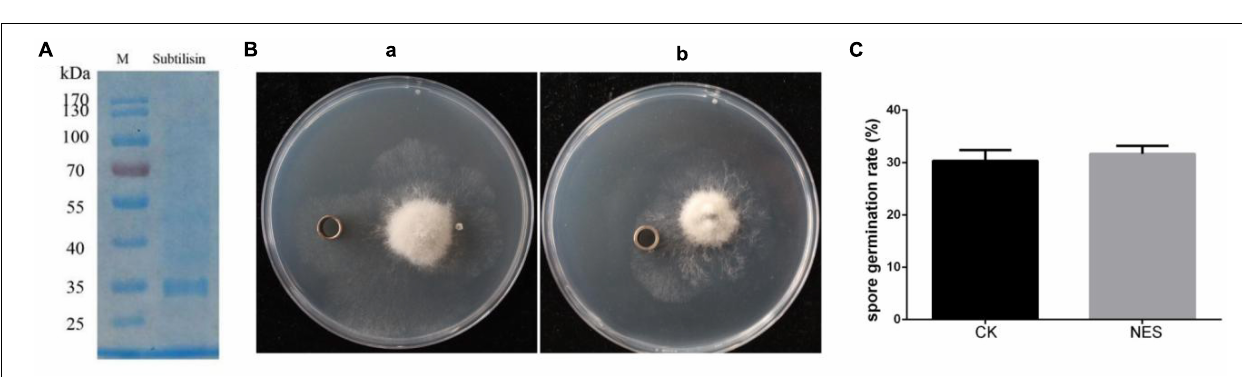
FIGURE 2 | Antifungal effect of subtilisin in vitro . (A) sodium dodecyl sulfate-polyacrylamide gel electrophoresis (SDS-PAGE) image of purified subtilisin protein, Molecular mass markers (M) indicated on the left from top to bottom is 170, 130, 100, 70, 55, 40, 35, and 25 kDa. (B) Antifungal experiment of buffer (a) and purified subtilisin (b) in vitro. After B. cinerea was cultured on the potato dextrose agar (PDA) medium for 3 days, 100 µ l of 100 µ g · ml − 1 subtilisin protein was added to the Oxford cup and placed in a 28 ◦ C incubator for 3 days, and then, the diameter of transparent circles around oxford cups was observed. (C) The effect of subtilisin on the B. cinerea germination. Data presented in (C) are the means ± SD from three independent experiments. The statistical analyses were performed using the Student’s t -test, and asterisks indicate significant